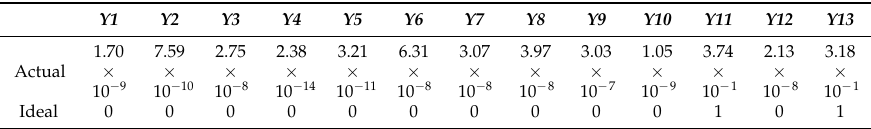
Table 8. The test results of a one symptom ( X 19) to two faults ( Y 11, Y 13)